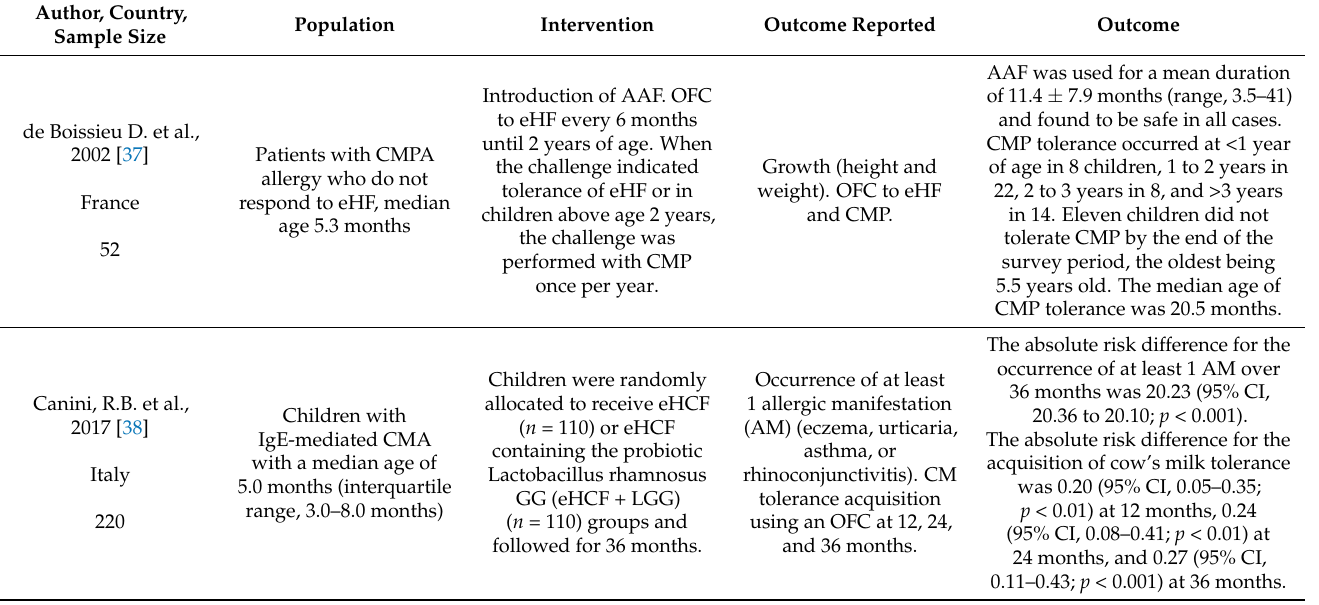
Table 2. Studies exploring methods of cow’s milk